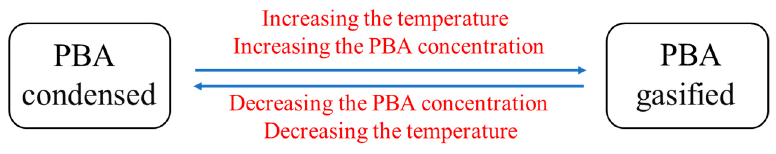
Figure 10. PBA gasification and condensation balance